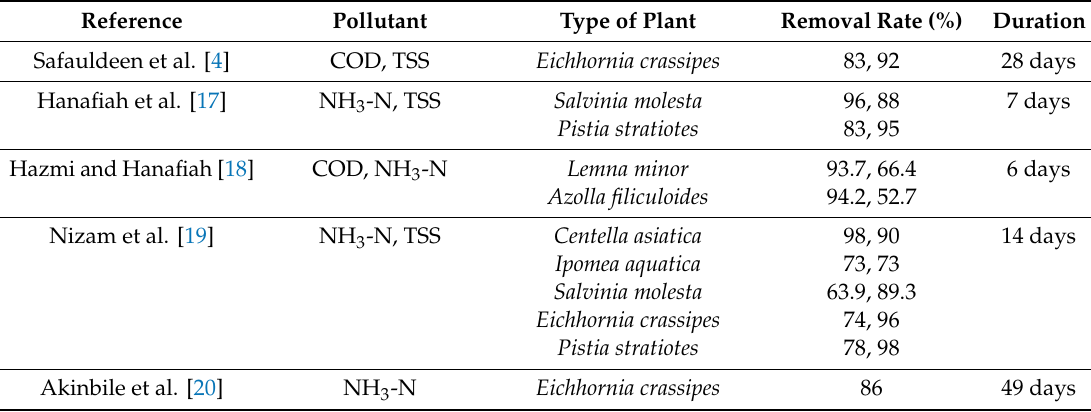
Table 1. The removal of total suspended solids (TSS), ammoniacal nitrogen (NH 3 -N) and chemical oxygen demand (COD) by phytoremediation treatment based on previous studies in